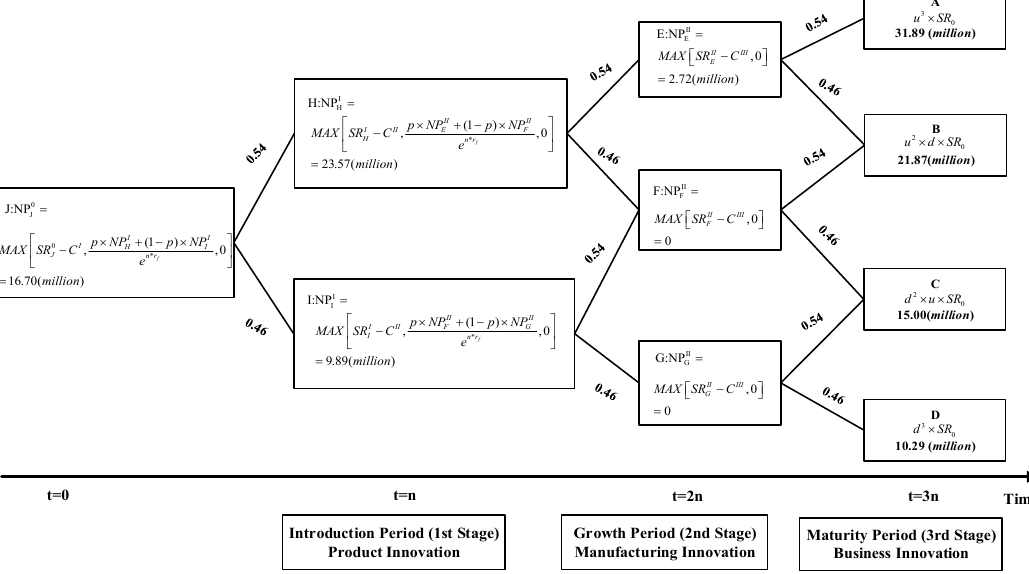
denotes the i denotes the